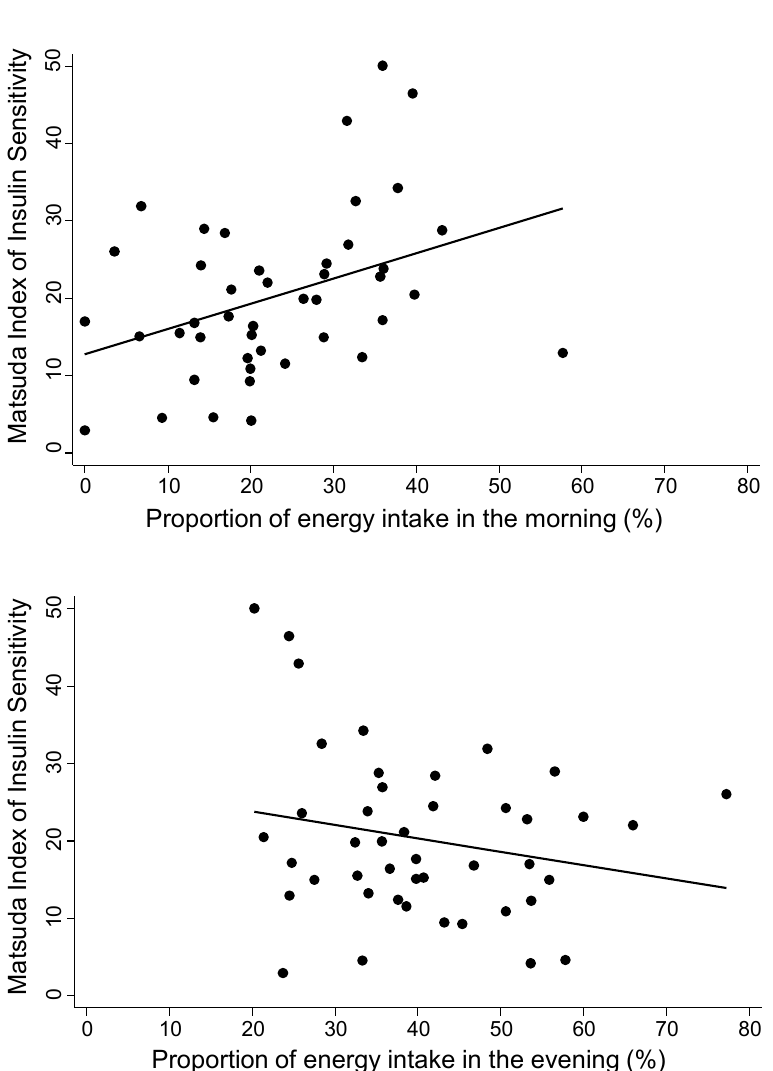
Figure 1. Associations between the Matsuda Index of insulin sensitivity and the proportion of energy intake in the morning ( top panel ) and the proportion of energy intake in the evening ( bottom panel ). The unadjusted regression line is plotted. The r values represent unadjusted Pearson correlations and associated p values.